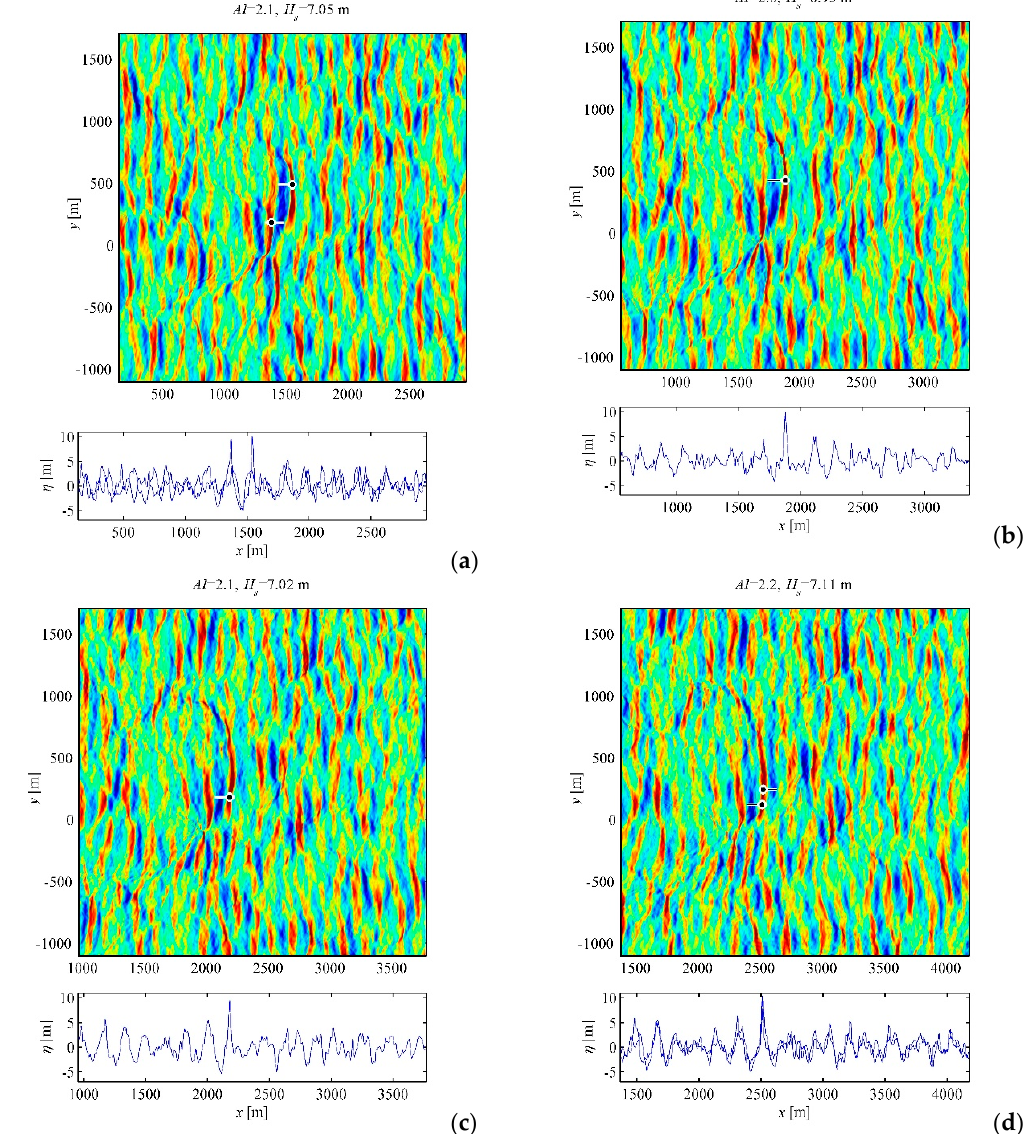
Figure 7. Same as in Figures 5 and 6, but a long-living rogue wave event from the series E 62 is shown. The snapshots correspond to the following instants of time: ( a ) 339 s; ( b ) 379 s; ( c ) 419 s; and ( d ) 459 s.